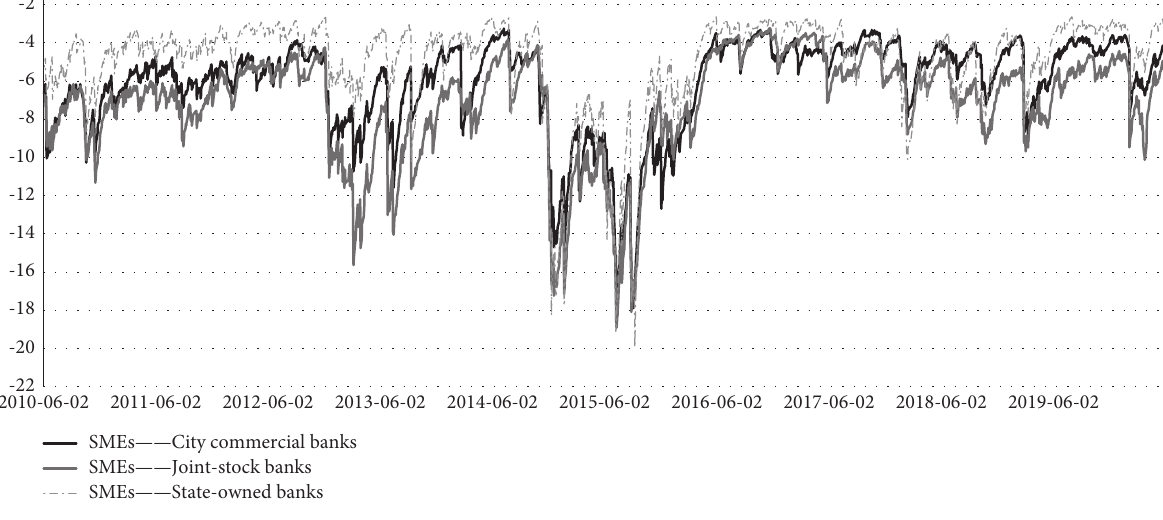
Figure 2: Risk spillover effects of SMEs on various banks ( △ CoVaR, α �